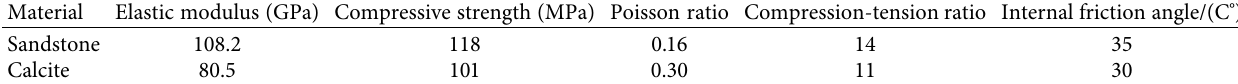
Table 2: Mechanical parameters of sandstone specimen.